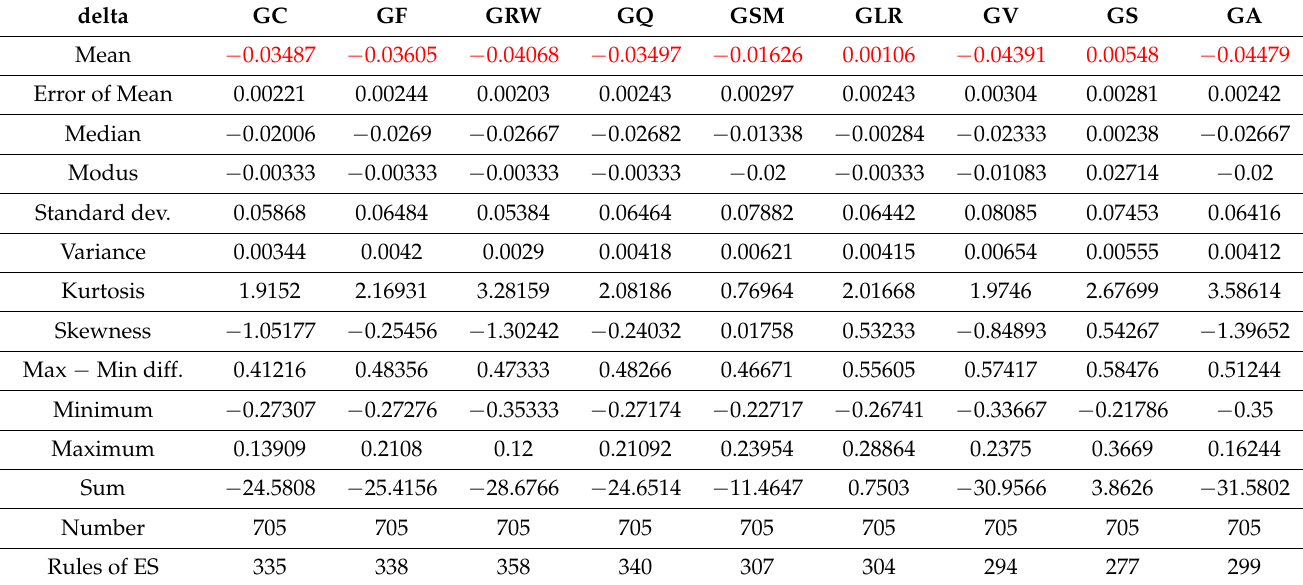
Table 12. Positive differences in the game-level assignment.